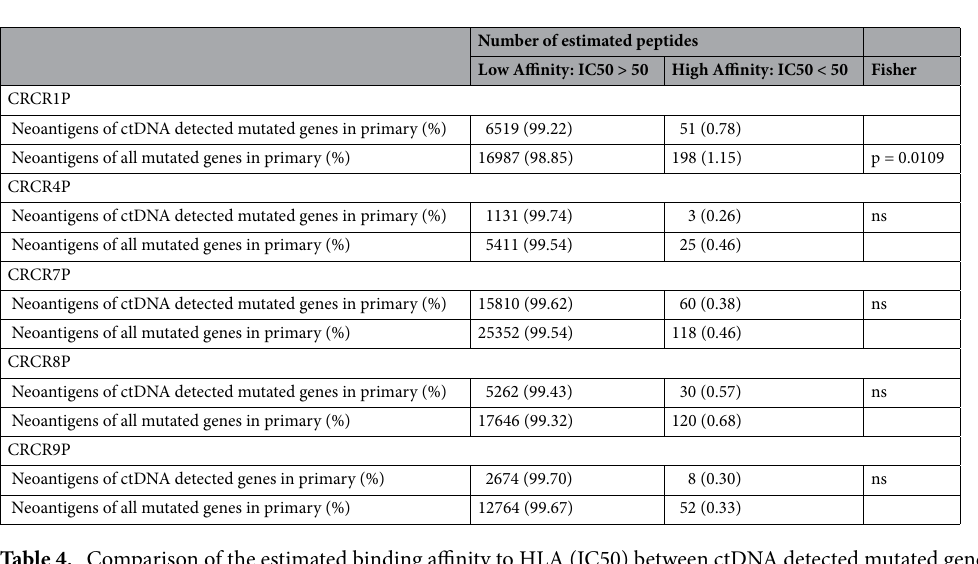
Table 4. Comparison of the estimated binding affinity to HLA (IC50) between ctDNA detected mutated genes and all mutated genes in primary